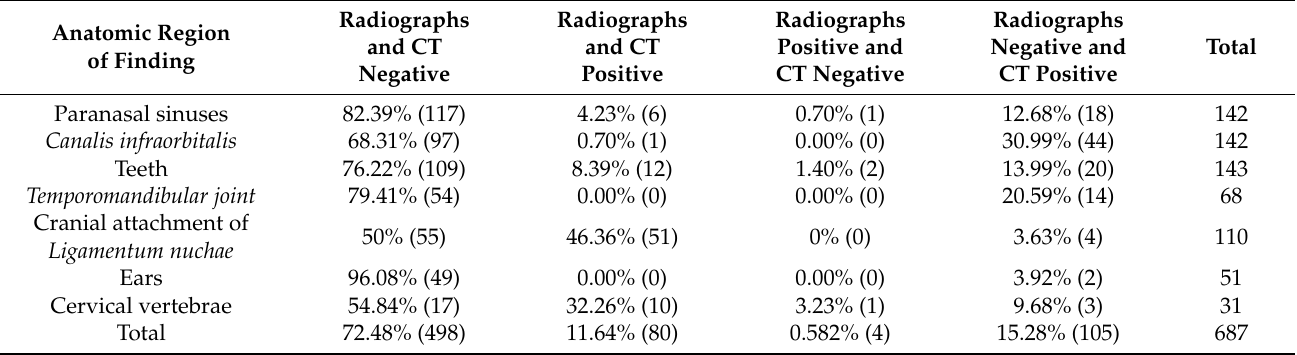
Table 2. Diagnostic findings in radiographs and computed tomography (CT) for different anatomic regions. Results of both imaging techniques in the same horse were compared (only inclusion of horses with conduction of both diagnostic techniques). Negative: without finding, positive: with